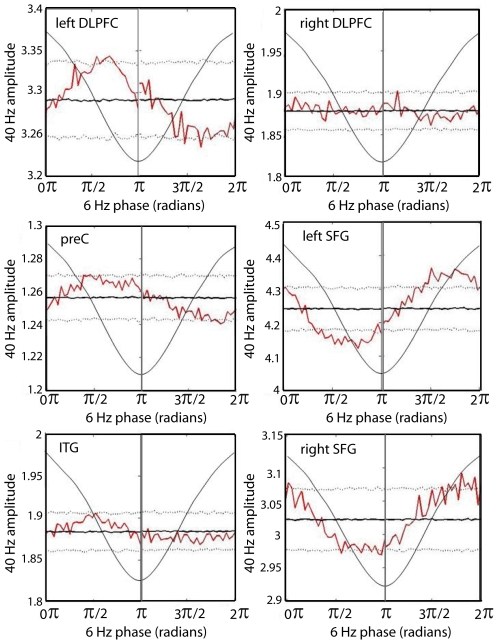
Theta-modulation of gamma amplitude.Dotted lines represent the 97.5 (top) and 2.5th (bottom) percentiles and the dark black line indicates the mean of the surrogate distribution for each of the 60 bins of the theta cycle. Jagged red line denotes the mean non-normalized gamma amplitude in each bin. When the gamma amplitude was greater than or less than the surrogate line for two or more successive bins we considered the departure to be significant (p<0.05, two tailed). Left PreCG and right PreCG plots are not shown; they resemble the plot for right DLPFC and show no significant relationship between theta phase and gamma amplitude. Radians on the x-axis are in reference to a cosine wave, which is maximal at 0 radians; one cycle of a 6 Hz cosine wave (thin black line) is superimposed on the graph.